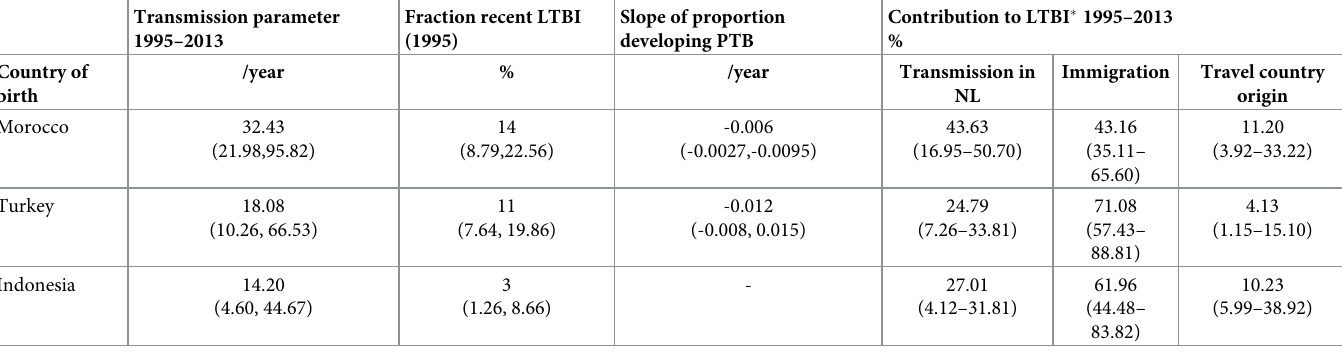
Table 2. Estimates for transmission rate, fraction recent LTBI in 1995 and contribution of different routes to LTBI in the Netherlands for three ethnic groups– Morocco-, Turkey- and Indonesia-born communities. In brackets the 95% confidence regions of the multivariate sensitivity analysis. Transmission parameter